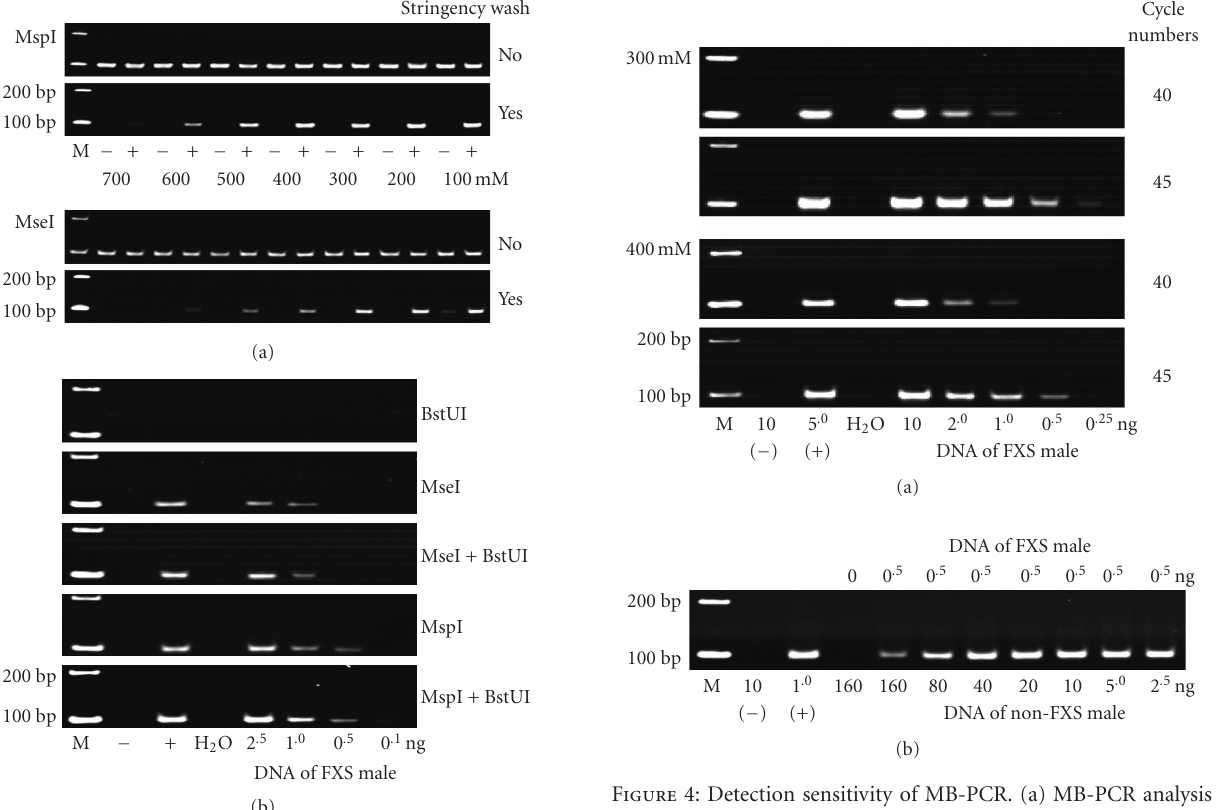
a nonmosaic methylation pattern with di ff erent amounts of DNA from a non-FXS male, ranging from 2.5 ng to 160 ng.